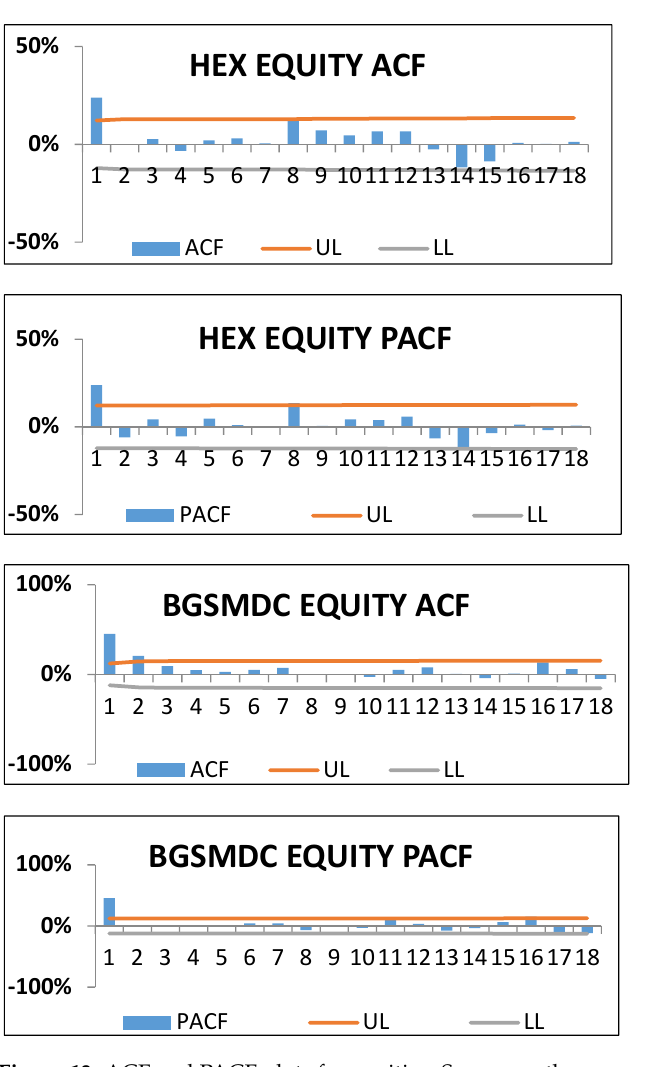
Figure 13. ACF and PACF plots for equities. Source: authors.